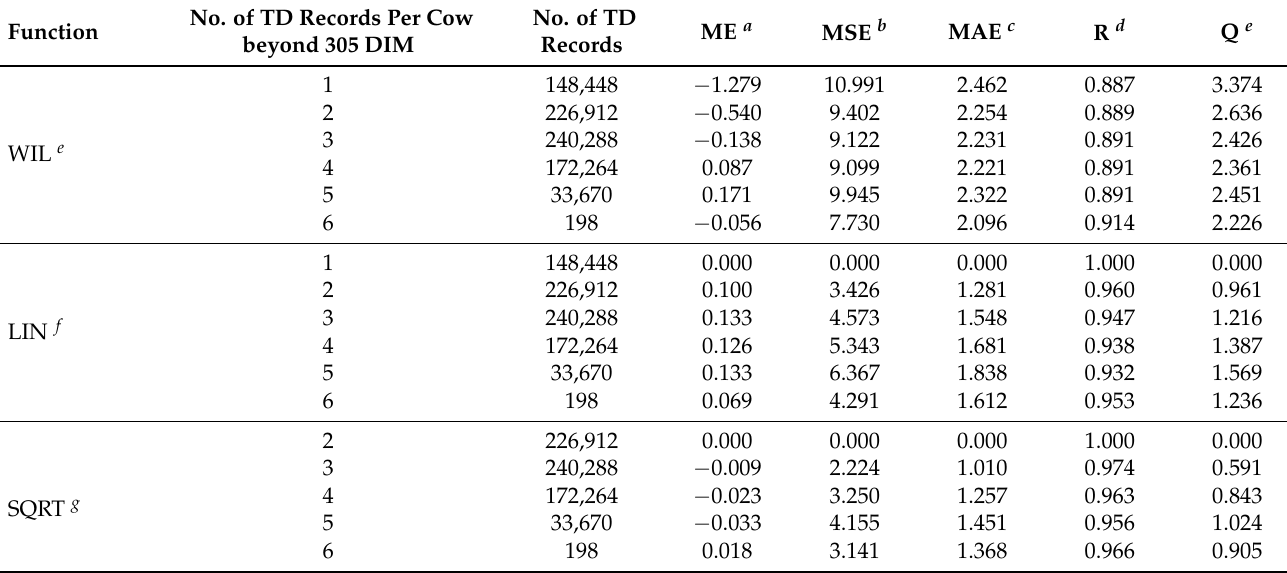
Table 6. Goodness of fit of WIL, LIN and SQRT functions to test-day (TD) milk yields beyond 305 day in milk by number of TD records per cow beyond 305